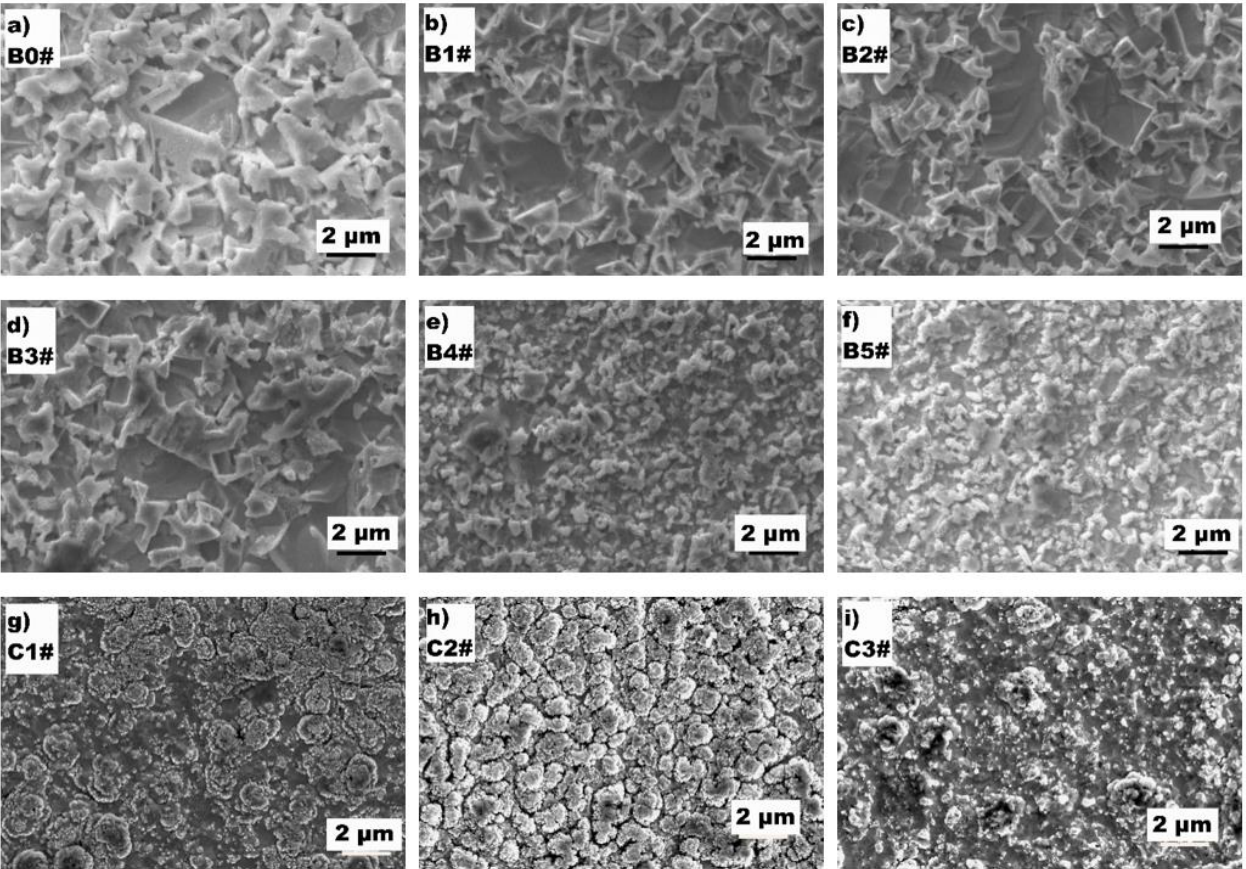
Figure 1. ( a ) The top-surface morphology of the alkali-etched WC-Co cermet (specimen B0#). ( b – i ) The surface morphologies of the specimens treated with different work gases.